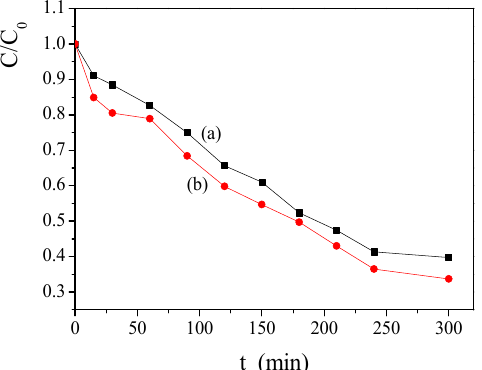
Figure 4. ( A ) Relative PY concentration, C/C 0 , as a function of time for the Fe 1 -NaY catalyst: (a) 30 ◦ C, (b) 40 ◦ C, (c) 45 ◦ C and (d) 50 ◦ C. Other reaction conditions: 50 mg of catalyst, V PY = 250 mL, C 0 = 30 ppm, initial pH = 3.00, C H2O2 = 12 mM and ( B ) TOC values determined at the end of reaction.